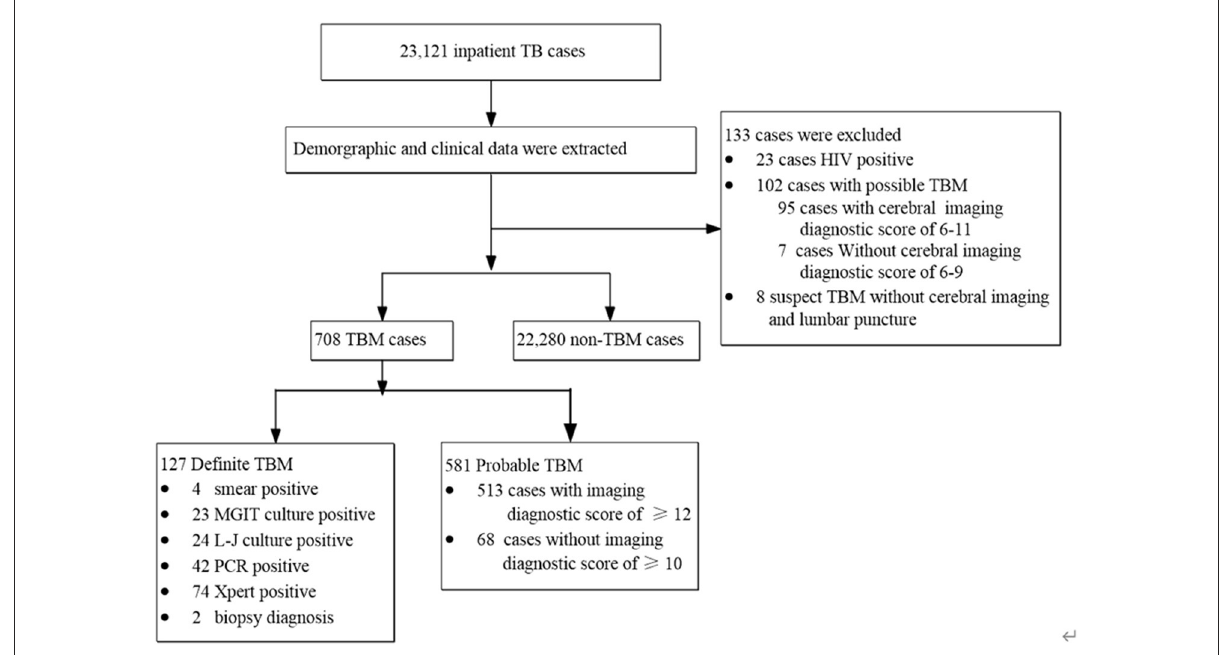
FIGURE1 Flowchart of subjects enrolled in the study.